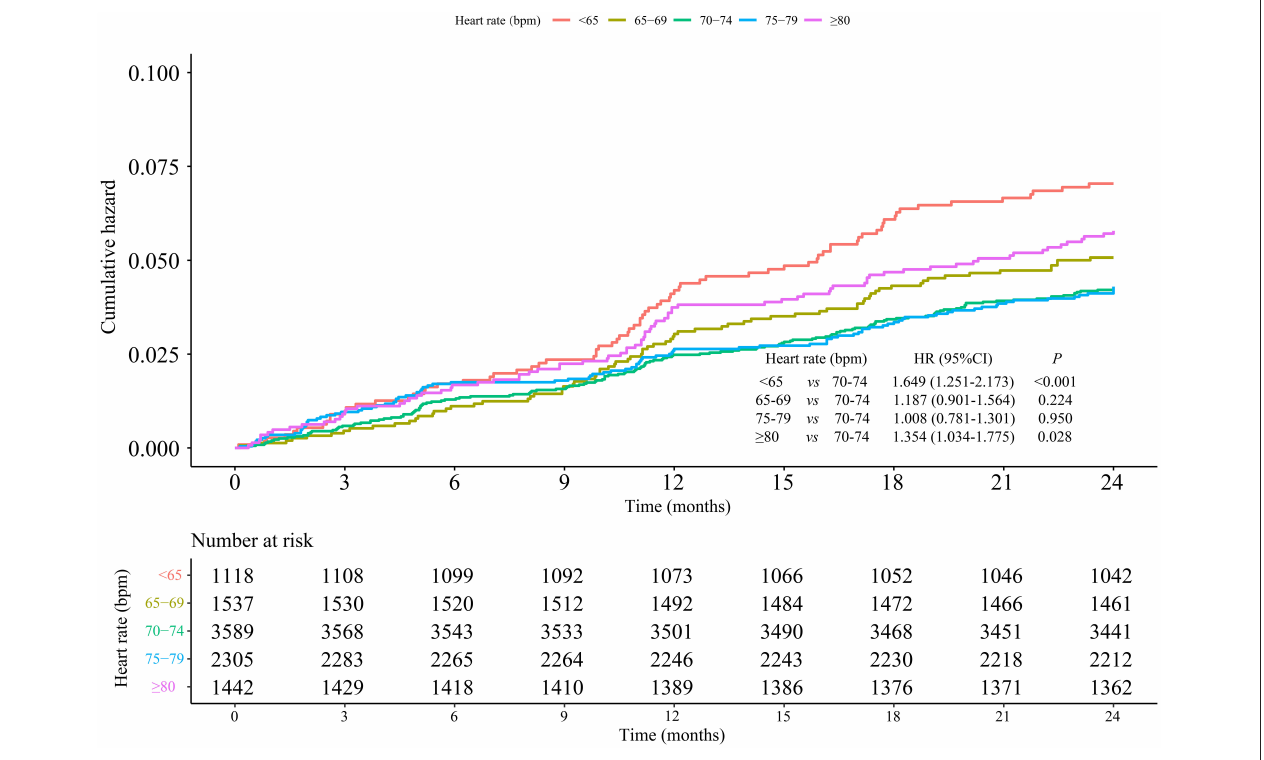
Frontiers in Cardiovascular Medicine |